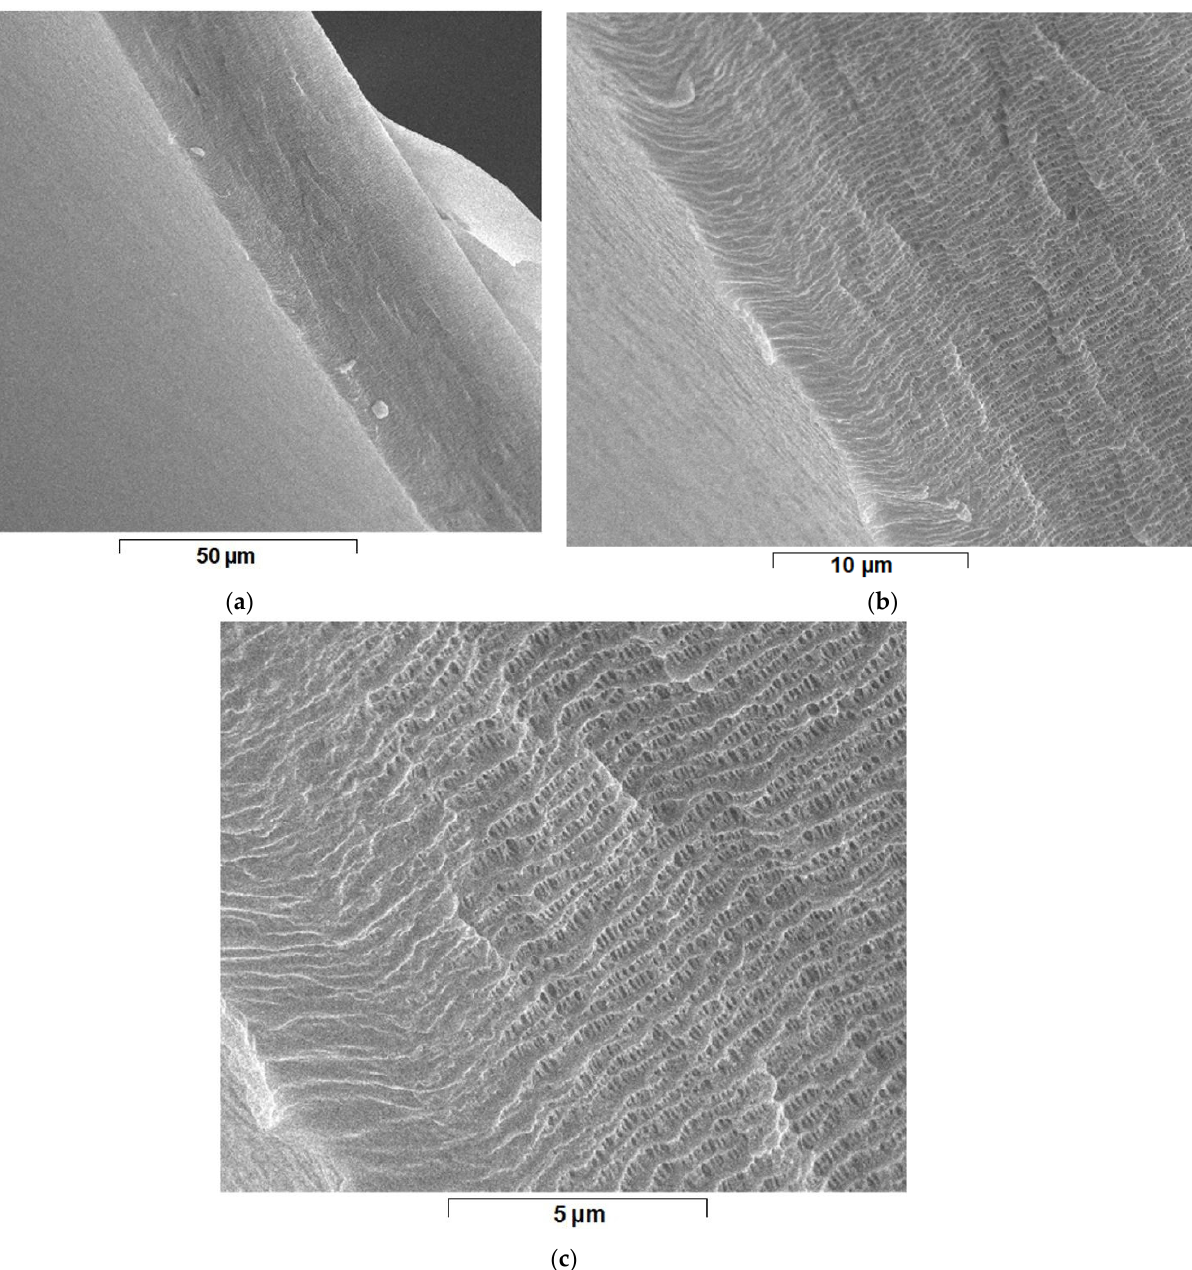
Figure 5. Scanning electron microscopy (SEM) of the uniformity of porosity and dimensional distribution of polypropylene hollow fibers membranes pores at various magnitudes: ( a ) ×2000; ( b ) ×8000; and ( c ) ×20,000.